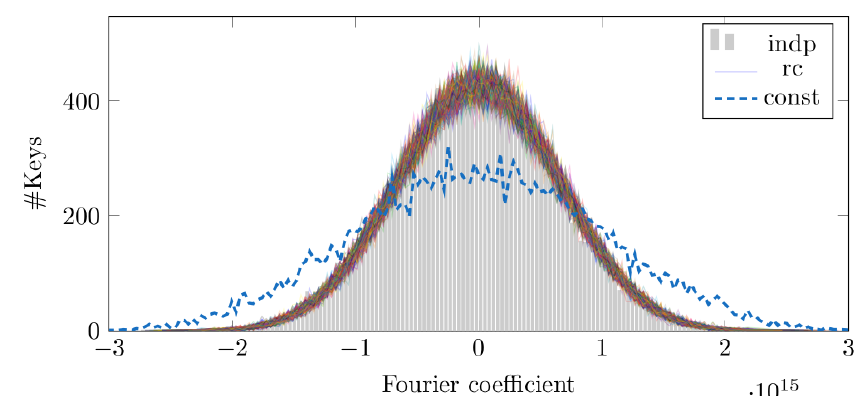
Figure 10: Experimental distributions for Present with different key schedules. The gray histogram is for independent random round keys. The dashed line is for identical round keys and an all zero round constant. All other lines, are for identical round keys and independent random round